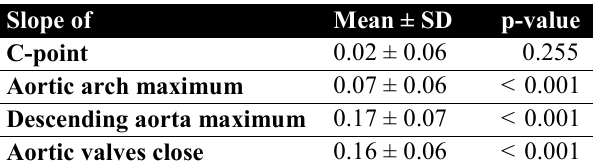
Table 3: The mean slopes and their standard deviations (SD) of the regression lines describing the time interval between the start of the ejection phase and the corresponding heart cycle marker. All slopes were found to differ from zero, except for the